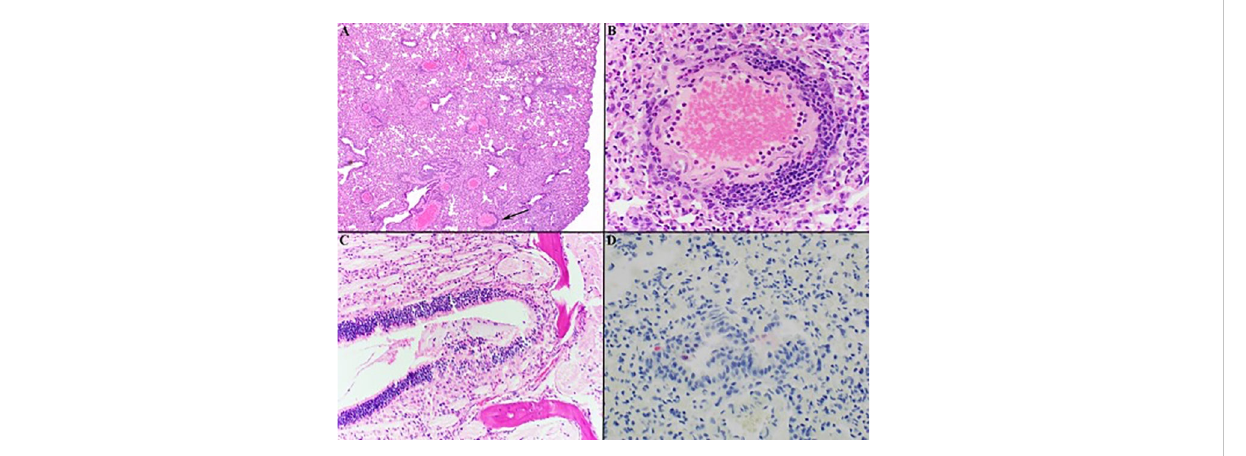
FIGURE 4 Histology of representative lesions in SARS-CoV-2 infected Peromyscus spp. Interstitial lymphohistiocytic pneumonia (A) Old fi eld mouse, 100x) was the most common fi nding with multifocal vessels with segmental reactive endothelium, neutrophilic margination, and perivasculitis (indicated by black arrow in (A) magni fi ed in (B) 400x). Necrosuppurative rhinitis was the second most common fi nding (C) California mouse, 200x). Anti-SARS-CoV-2 IHC shows rare positive labeling (red) of bronchial epithelial cells within the lungs (D) Sonora white-footed mouse, 400x). Hematoxylin